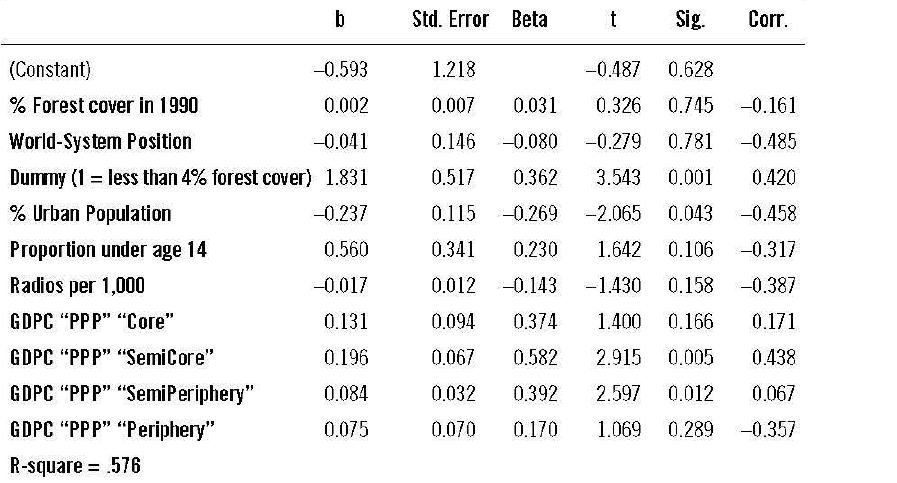
Table 4b. - Contextual 4-Dummy Model for Gross Domestic Product "PPP" b Std. Error